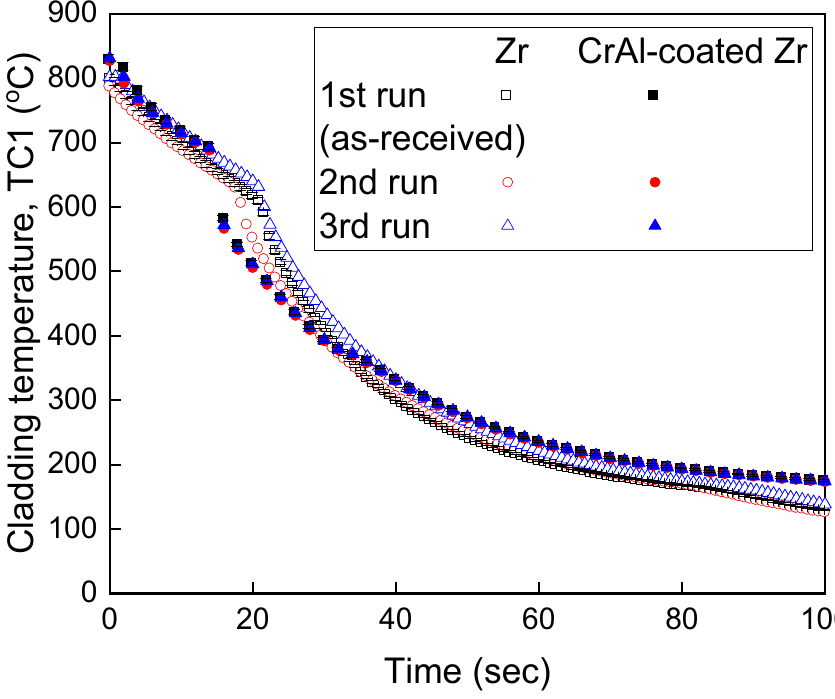
Figure 10. Repeatability of quenching tests for Zr cladding and CrAl-coated Zr cladding.